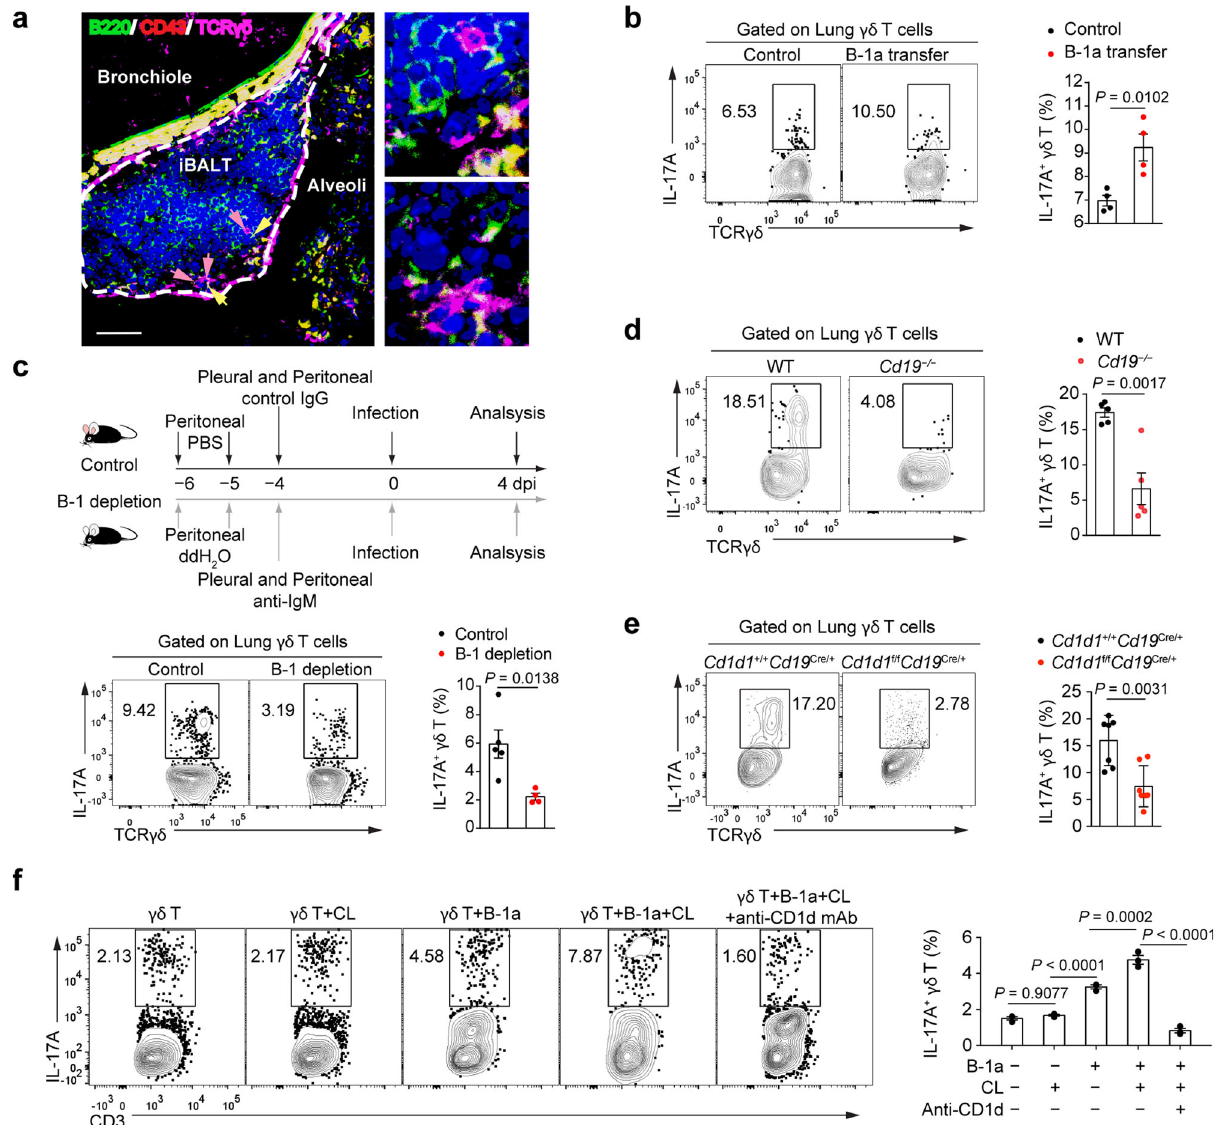
Fig. 6 γδ T IL-17A production requires CD1d-dependent antigen presentation. a Confocal immuno fl uorescence microscopy of lungs from pdmH1N1- infected mice at 3 dpi, stained for B220 (green), CD43 (red), TCR γδ (purple), and DAPI (blue). Outlined areas (left row) are enlarged 10× at right. Scale bar, 50 μ m. b Mice at 1 dpi were i.v. injected with 5 × 10 5 CL-preloaded B-1a cells and analysed by fl ow cytometry at 5 dpi. Flow cytometry plots (left) and cumulative data (right) showing frequency of IL-17A + cells in gated lung CD3 + TCR γδ + cells ( n = 4). c Schema of B-1a cell depletion. Mice were infected with pdmH1N1 and analysed at 4 dpi. Representative fl ow cytometry plots (left) and cumulative data (right) showing frequencies of IL-17A + cells in gated lung CD3 + TCR γδ + cells ( n = 5, 4). d CD19-de fi cient ( Cd19 − / − ) and WT mice were infected with pdmH1N1 and analysed at 5 dpi. Representative fl ow cytometry plots (left) and cumulative data (right) showing frequencies of IL-17A + cells in gated lung CD3 + TCR γδ + cells ( n = 5). e CD 1d1 + / + CD 19 Cre/ + and control CD 1d1 f/f CD 19 Cre/ + mice were infected with pdmH1N1 and analysed at 5 dpi. Representative fl ow cytometry plots (left) and cumulative data (right) showing frequencies of IL-17A + cells in gated lung CD3 + TCR γδ + cells ( n = 7). f Puri fi ed γδ T cells (1 × 10 5 /well) were cultured 1:4 with B-1a cells from naïve C57BL/6 mice with or without CL, and with 10 μ g/mL anti-CD1d blocking antibody or isotype control antibody for 3 days. IL-17A production in γδ T cells was determined by fl ow cytometry. Representative fl ow cytometry plots (left) and cumulative data (right) showing frequency of IL-17A + cells in gated γδ T cells ( n = 3). Data are combined from two or three independent experiments and are represented as mean ± SEM. P- values were determined using two-tailed unpaired Student ’ s t -test ( b – e ) or one-way ANOVA ( f ). Source data are included in Source Data fi